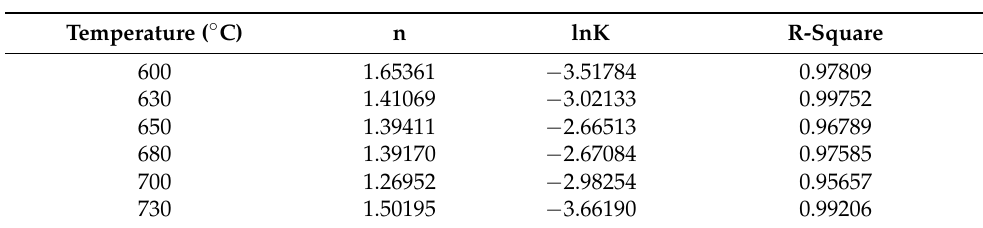
Table 6. Values of n and lnK.